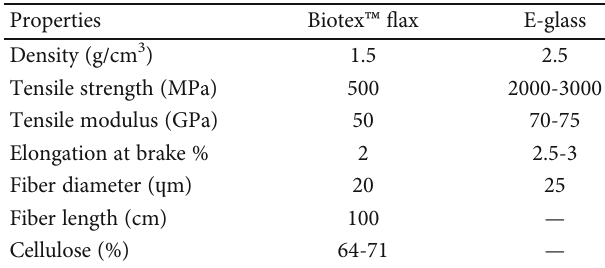
Figure 1: Reinforcement for composite FS: (a) fl ax fabric and (b) glass fabric. Table 1: Speci fi cations of reinforcement fi bers [8,